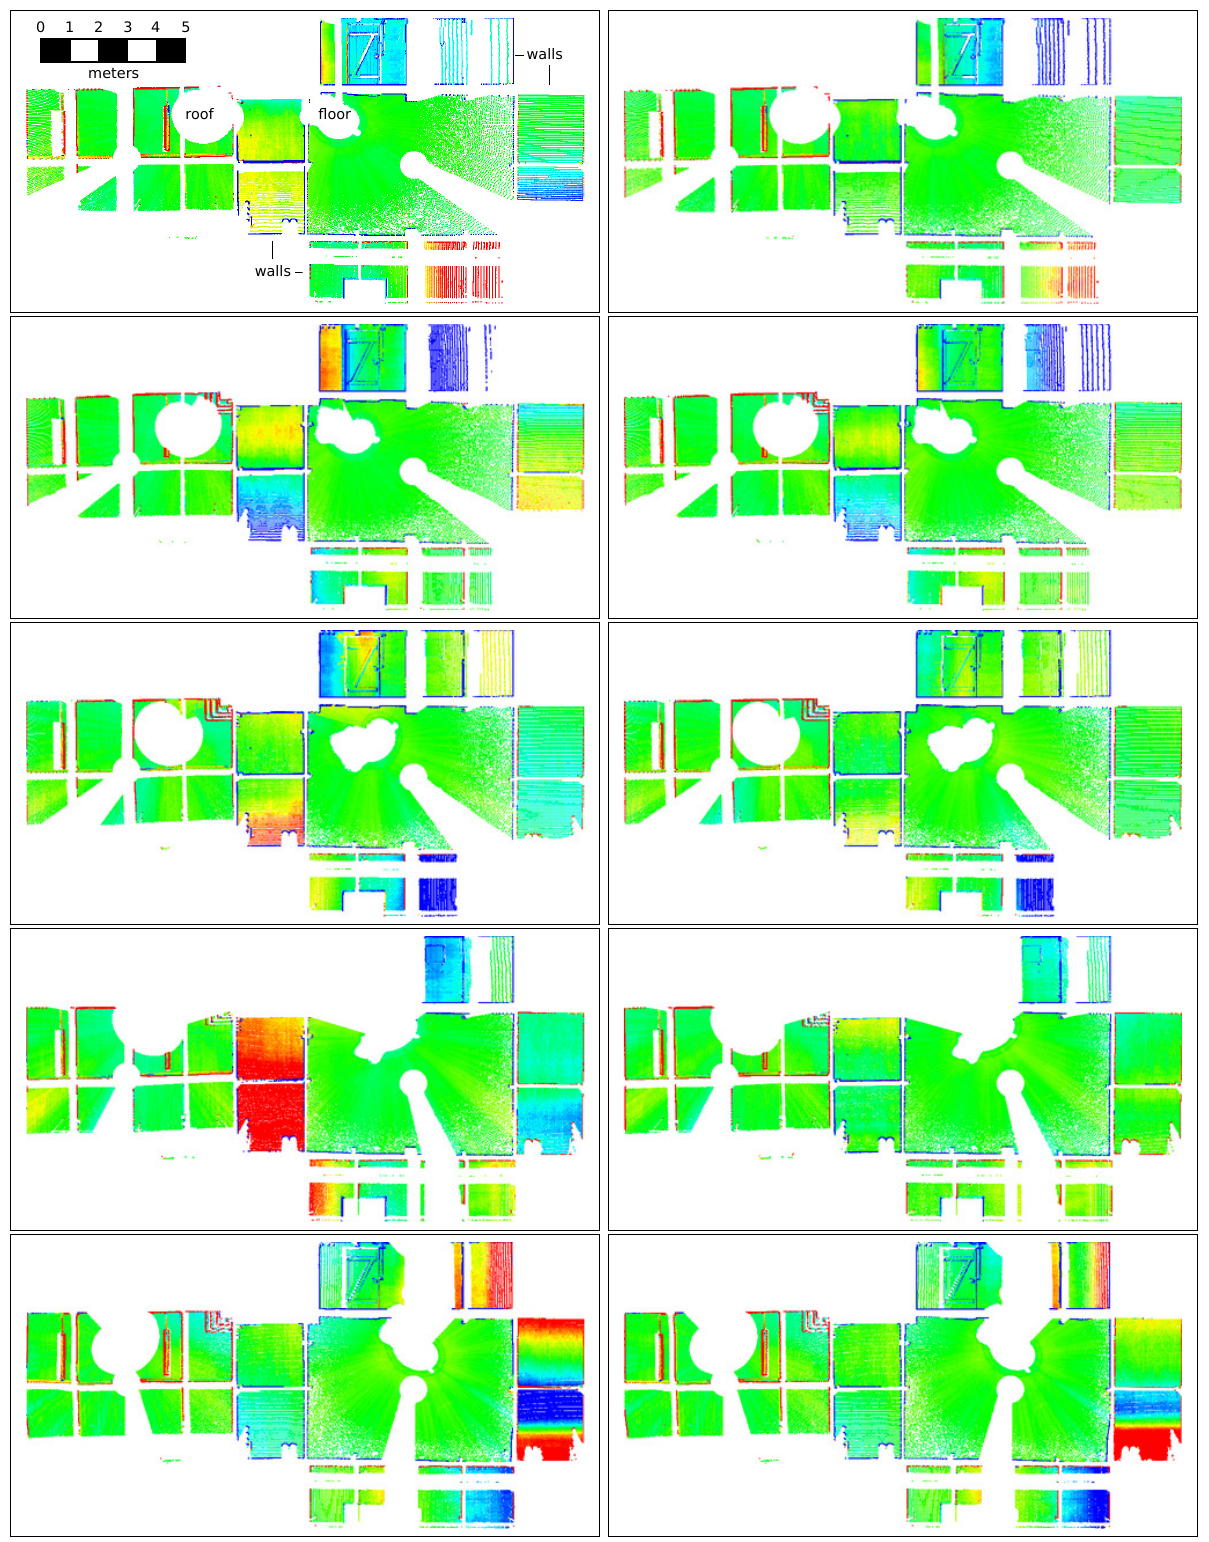
Figure 11. Comparison of the 5 acquired laser scans from Basement 2 with the model using the initial ( Left ) and the automatic semi-rigid registration ( Right ). Deviations in cm are color-coded as indicated in Figure 6. Note: best viewed in